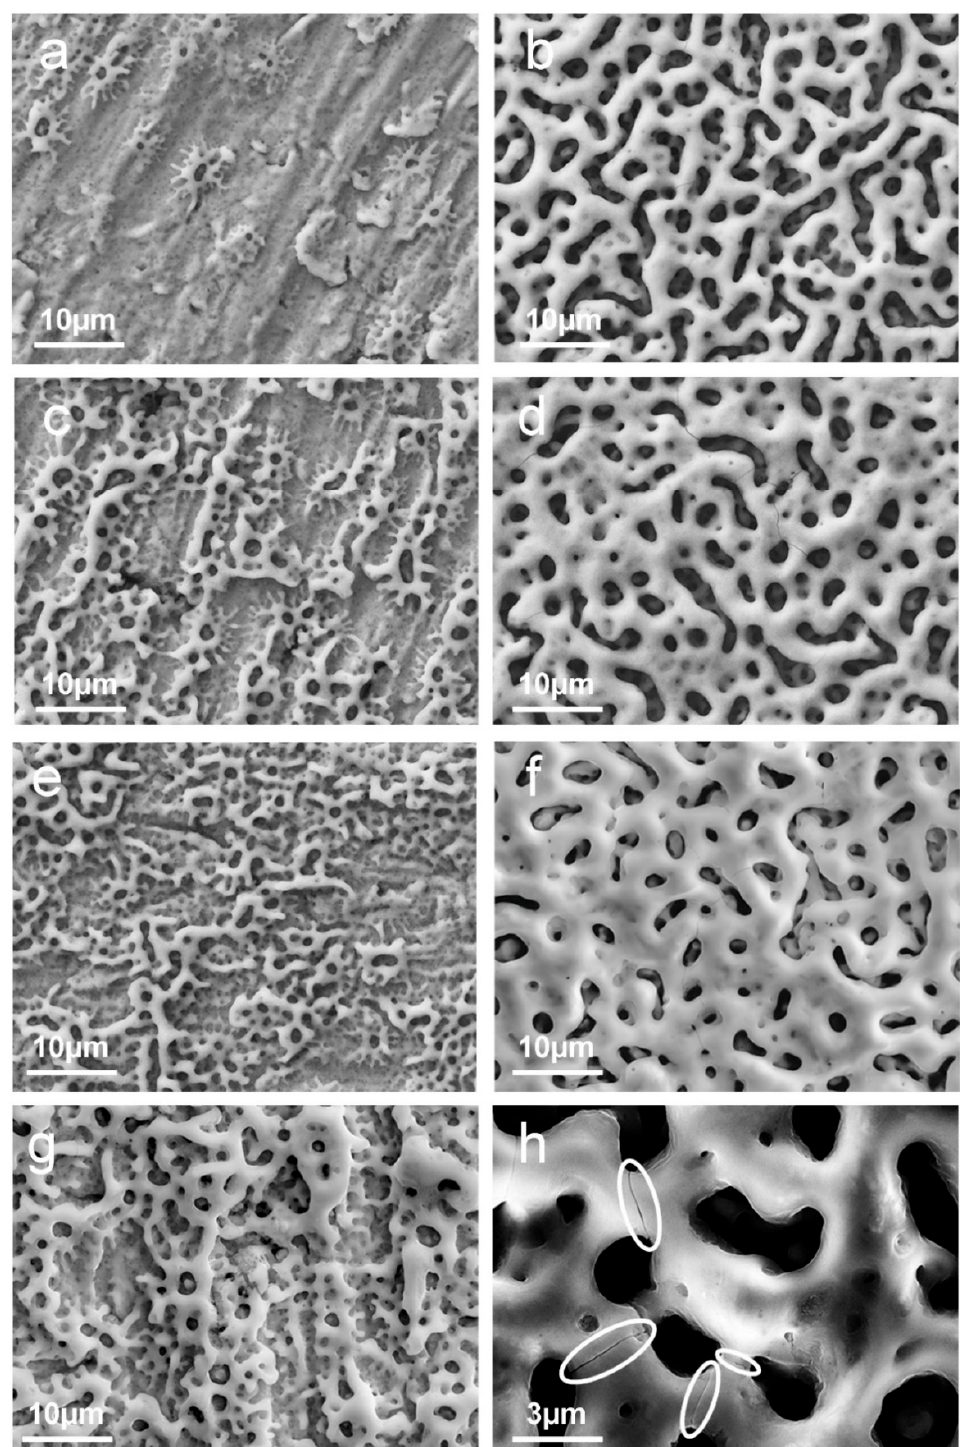
Figure 1. Representative top view SEM images (E–T detector) of anodized sample at limiting potential of 200 V (left column) and 250V (right column) in different conditions: for ( a , b ) galvanostatic process, ( c , d ) galvanostaic/potentiostatic (60 s), ( e , f ) galvanostaic/potentiostatic (300 s), and ( g ) galvanostaic/potentiostatic (30 min). ( h ) High magnification of the fractures (circled) observed in samples anodized in pure galvanostatic regime at 250 V (10 s).